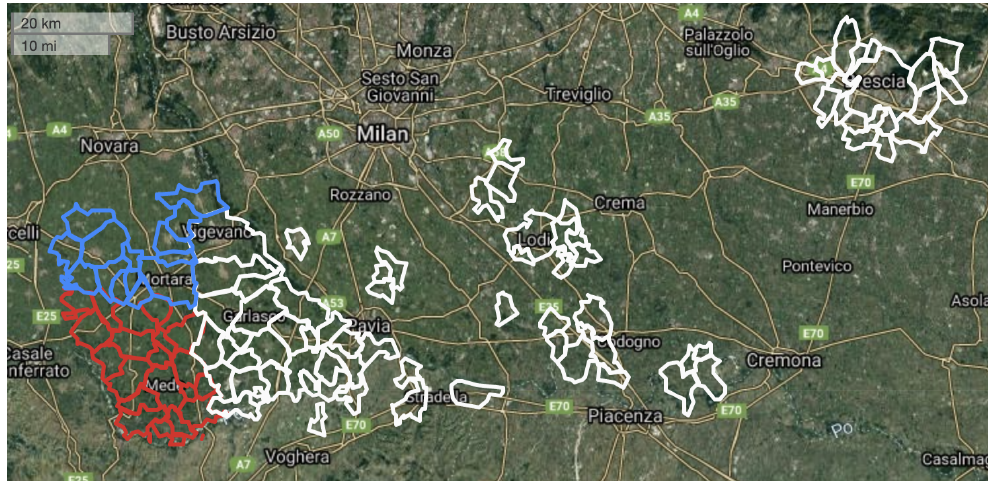
Figure 2. Geographic split of the dataset based on the analyzed cities (polygons): training (white), validation (blue), and testing (red). Map layers provided by GoogleMaps